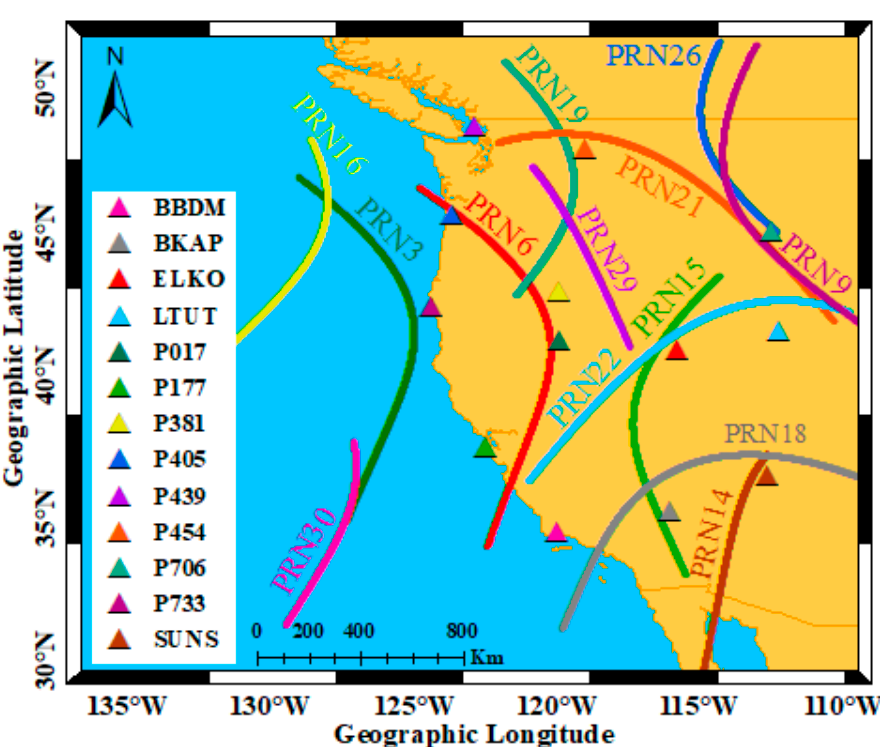
Figure 5. Location of sample GPS stations and IPP paths between 15:00 UT and 20:00 UT over west American coast on 11 March. The spatial distribution of GPS stations are shown with different colors. For each station, IPPs of only one satellite path is depicted, which has the same color.